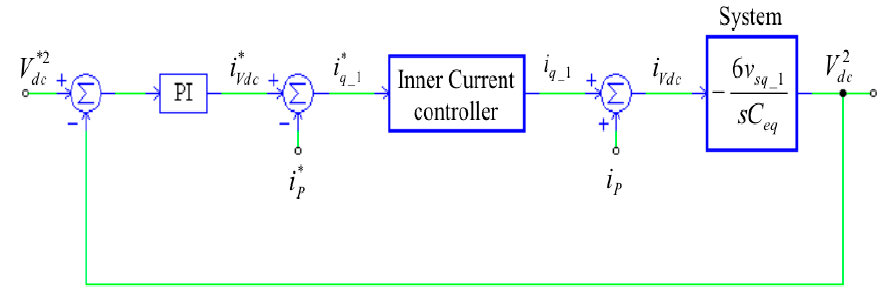
Figure 7. Control diagram of the DC-Link voltage .